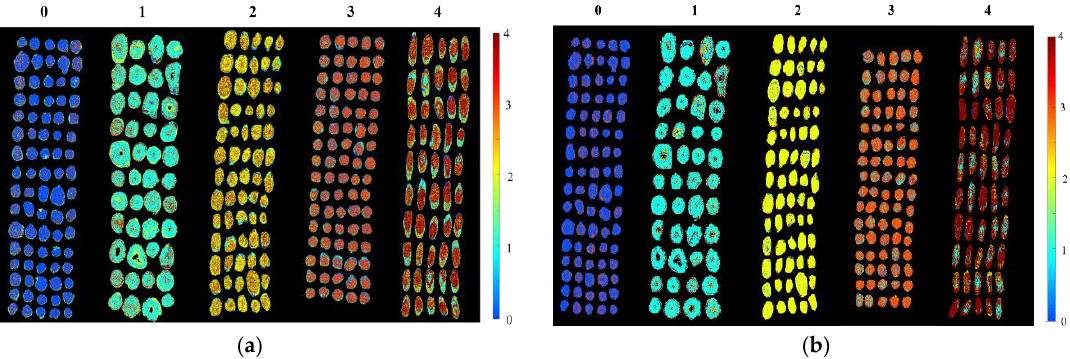
Figure 6. Prediction map for Radix Astragali of all the geographical origins based on the CNN model using full wavelengths: ( a ) prediction map using Vis-NIR spectra; and ( b ) prediction map using NIR spectra.